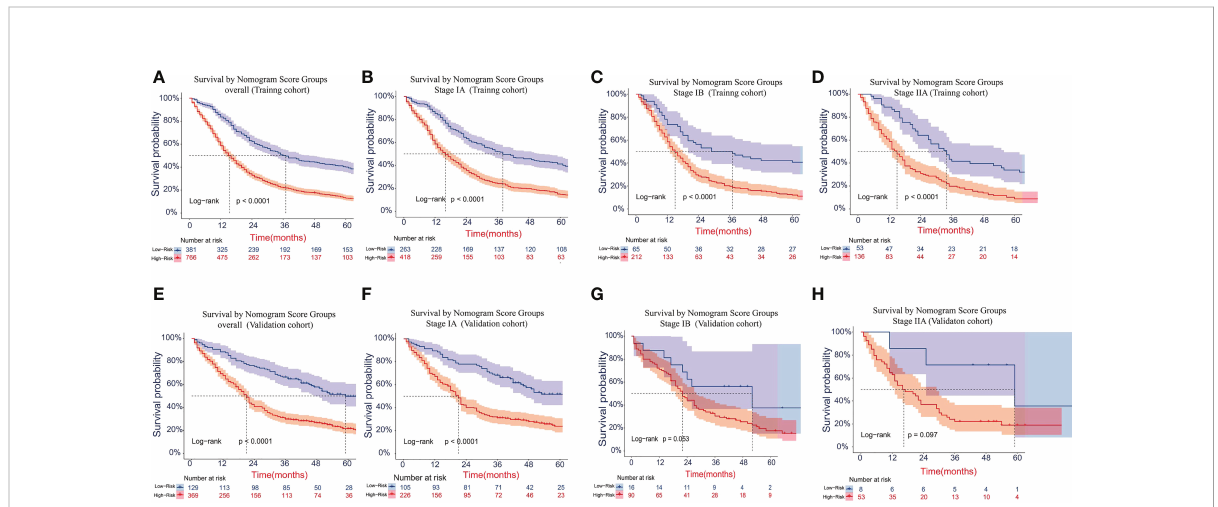
FIGURE 8 Kaplan – Meier survival curves for OS in the overall and stage-strati fi ed patients in the training (A – D) and validation (E – H) cohorts to test the risk strati fi cation system based on the training cohort. The red line represents the high-risk group, and the blue line represents the low-risk group. OS, overall